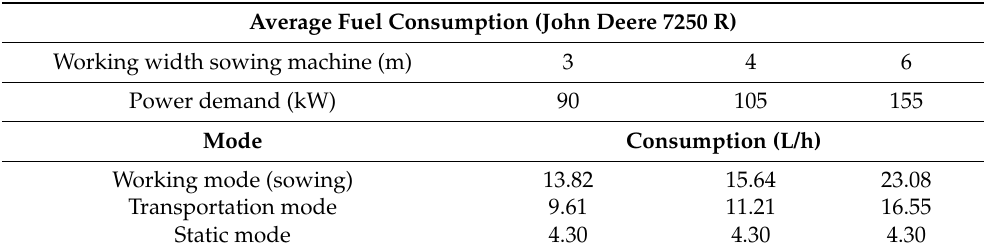
Table 2. Average fuel consumption for different modes of tractor operation